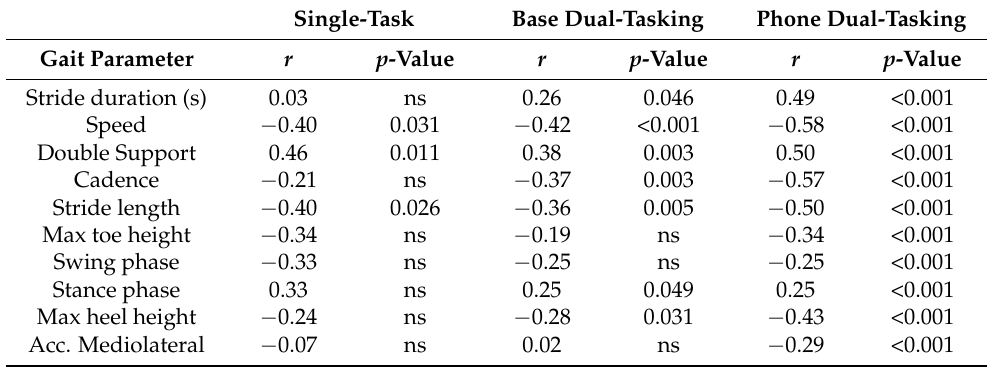
Table A2. Results of applying Pearson to search for correlations between normalized gait variables and age when performing normal gait and